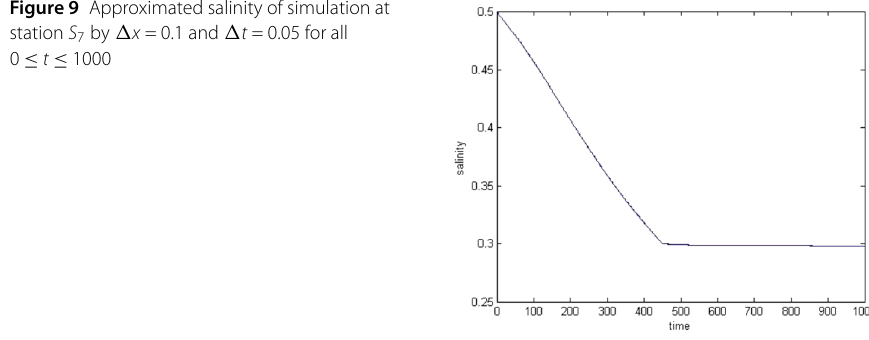
Figure 9 Approximated salinity of simulation at station S 7 by (cid:4) x = 0.1 and (cid:4) t = 0.05 for all